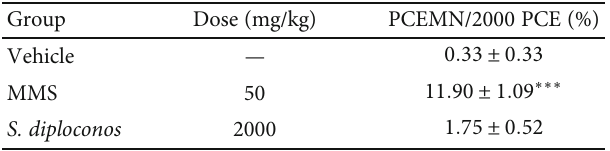
Table 1: Percentage of polychromatic erythrocyte (PCE) micronuclei (PCEMN) in animals treated with S. diploconos fruit extract. Percentage of polychromatic erythrocyte (PCE) micronuclei (PCEMN) in the micronucleus assay performed in erythrocytes obtained from the bone marrow (the values are expressed as mean ± SEM ( n = 5 ). ∗∗∗ p < 0 : 001 vs. the vehicle